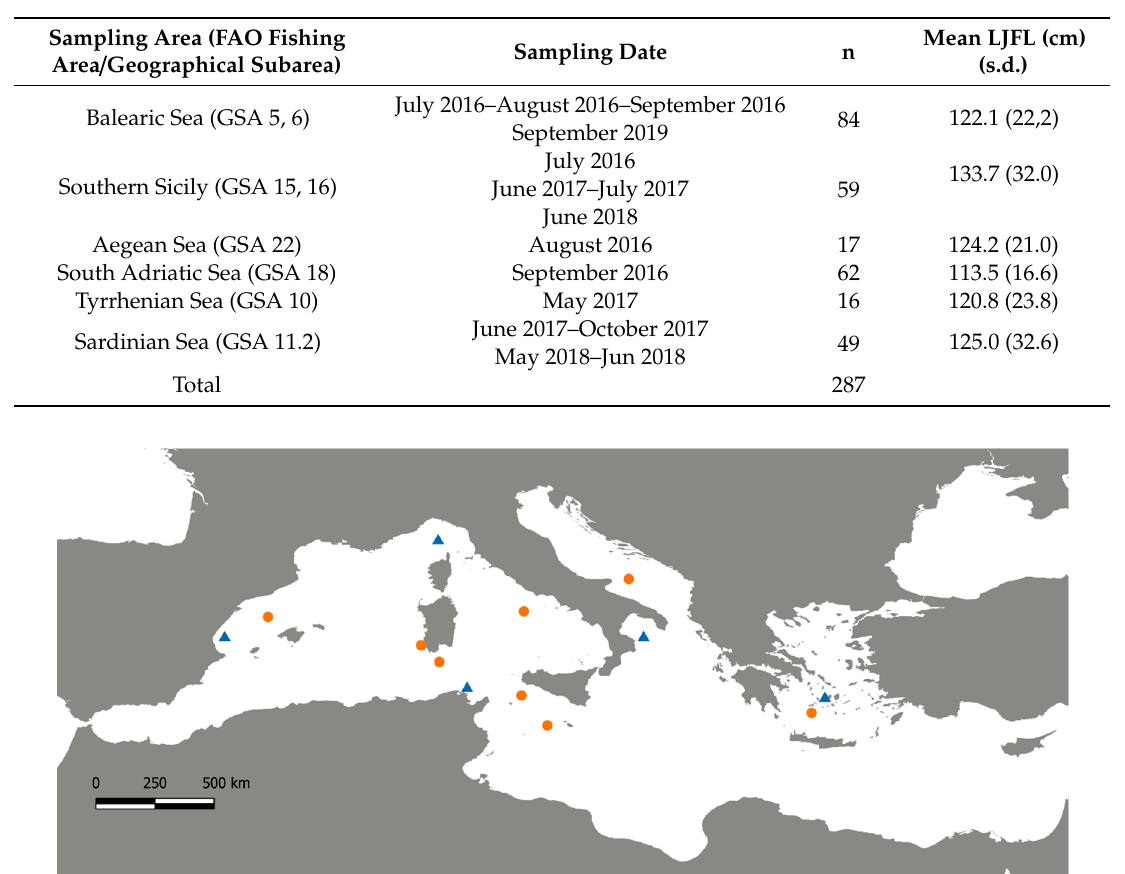
Figure 1. Map of the Mediterranean Sea with the Swordfish sampling sites. Blue triangles represent historical sampling localities from Viñas et al. [17] and orange dots represent sampling locations of current Swordfish samples.